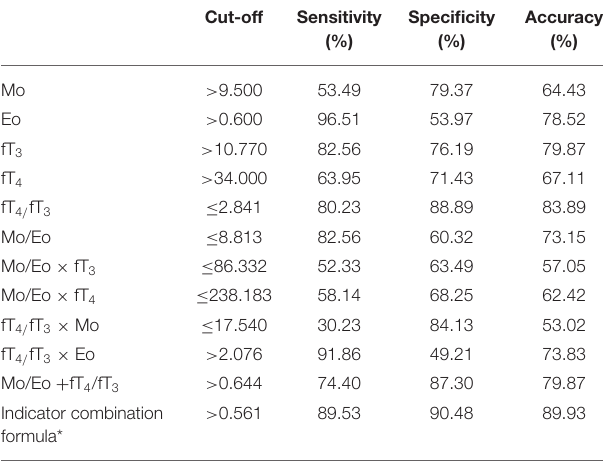
TABLE 3 | Diagnostic evaluation of cut-off levels of various indexes in untreated Graves’ disease. Cut-off Sensitivity (%)